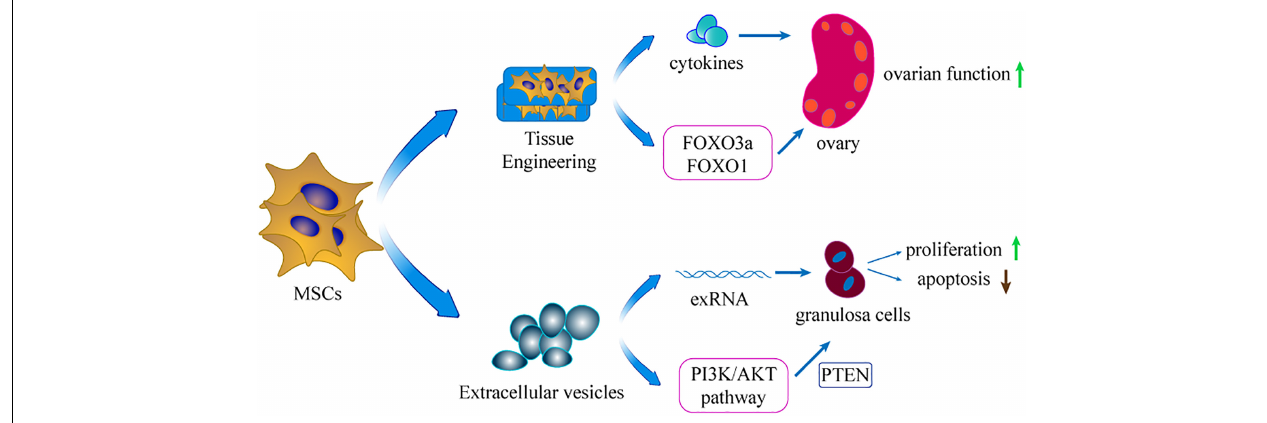
FIGURE 3 | The extension of applicating MSCs. Using extracellular vesicles of MSCs and tissue engineering is the extension application of MSCs in treating